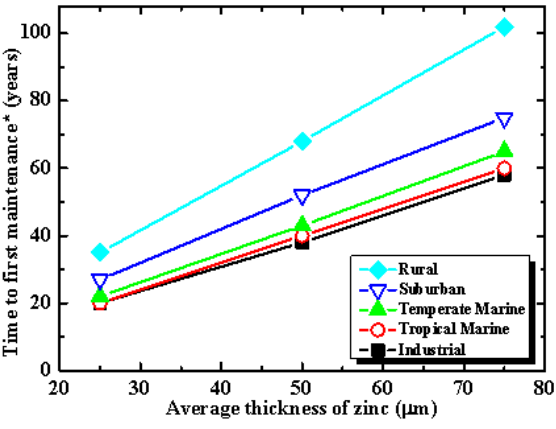
Figure 7. Corrosion rate of zinc in different environments.